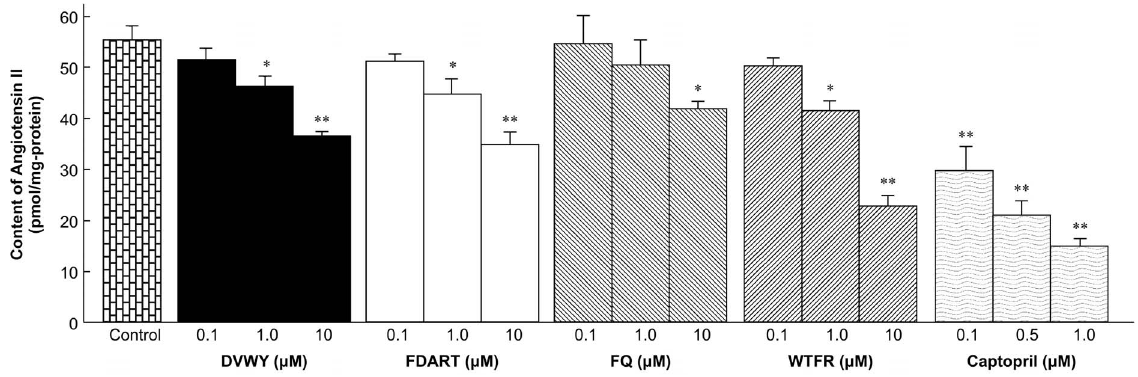
Figure 3. Angiotensin II production after incubation with angiotensin I and DVWY, FDART, FQ, WTFR, and captopril. Angiotensin II production was measured in SHR aorta rings incubated in 0.2 m M angiotensin I with DVWY, FDART, FQ, WTFR, and captopril (positive control). Data represent the mean 6 S.E. (n=3). * p , 0.05, ** p , 0.01 versus the negative control group (Krebs solution treatment), Student’s t -test. doi:10.1371/journal.pone.0105802.g003 PLOS ONE |